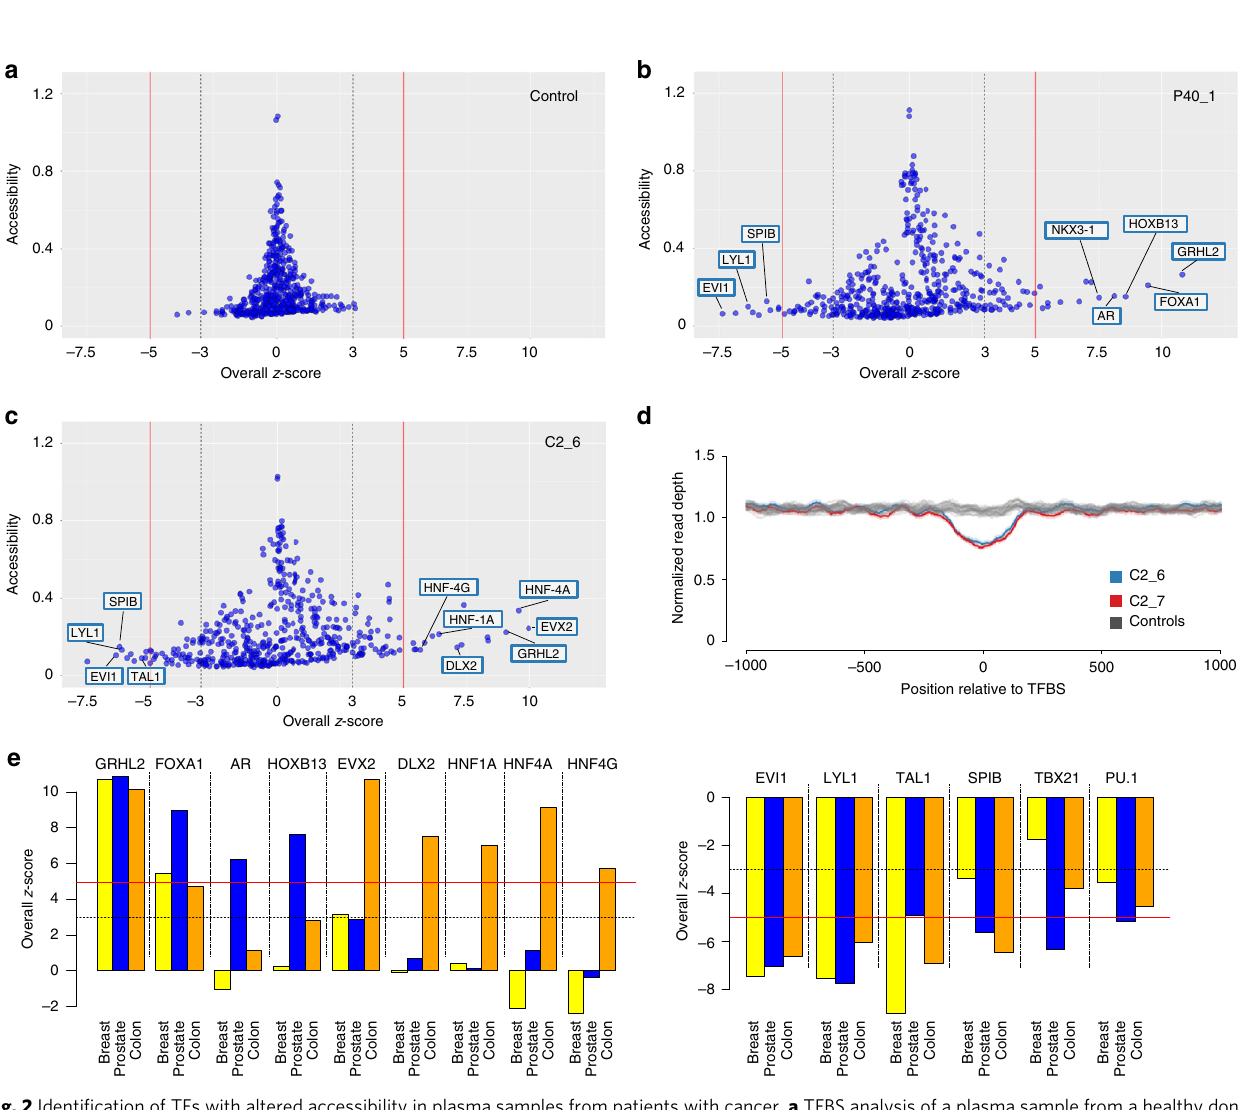
Fig. 2 Identi fi cation of TFs with altered accessibility in plasma samples from patients with cancer. a TFBS analysis of a plasma sample from a healthy donor (NPH001). Each point represents a TF, the y -axis displays the accessibility values, and the x -axis illustrates the overall z-score, as a measure of deviation in accessibility from normal control samples. In the samples from healthy donors (compared with every remaining healthy donor), only a few TFs exceeded a z-score of ±3 (dotted gray lines) and none the ±5 z-score (red lines) threshold. b An overall z-score plot as in ( a ), but with a plasma sample derived from a patient with prostate cancer (P40). c Overall z-score plot as in ( a ) for plasma sample C2_6. d Nucleosome position pro fi les from plasma DNA of healthy controls (gray pro fi les) and two plasma samples derived from a patient C2 with colon cancer (blue and red) for TF EVX2. e Bar charts of overall z-score plots for merged breast, prostate, and colon pools. The left panel displays TFs with increased accessibility in at least one tumor entity; the right panel summarizes the accessibilities of hematopoietic-related TFs. Bars represent single data